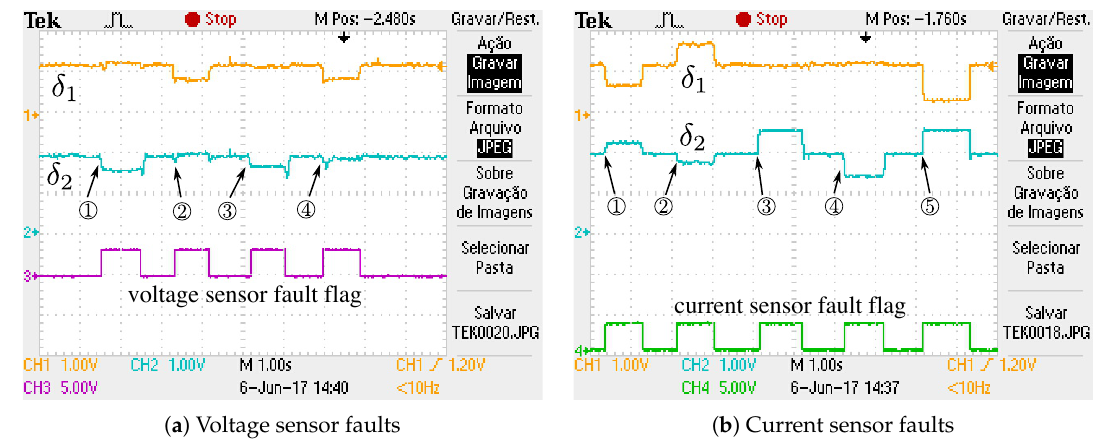
Figure 18. Experimental FDI in sensors using δ 1 and δ 2 signals.